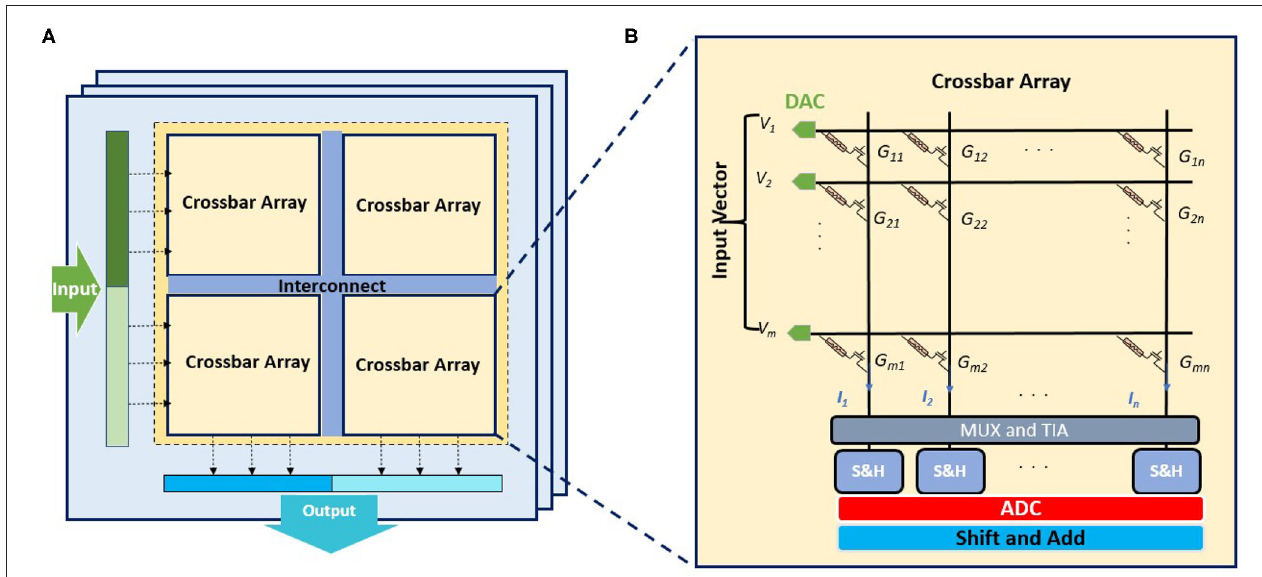
FIGURE 11 | In-memory computing architecture involving multiple tiles of interconnected crossbar arrays to process high dimensional MVM operations with high bit precision. (A) Illustration of the multi-tile architecture for executing large input vector with high bit precision where multiple crossbars will be used for mapping the input and weight matrix. (B) Illustration of the circuit of a single crossbar array comprising the array of synaptic devices in series with access transistors and peripheral analog and digital circuits. A multiplexer (MUX) and transimpediance amplifier (TIA) are directly connected to the crossbar columns, followed by sample and hold circuit (S&H) as well as ADC and shift and add